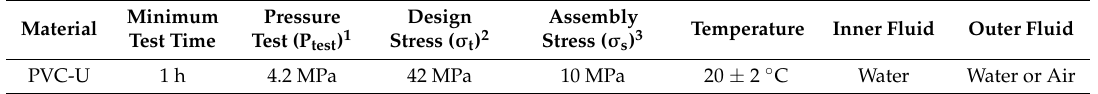
Table 2. Shell test parameters for PVC-U